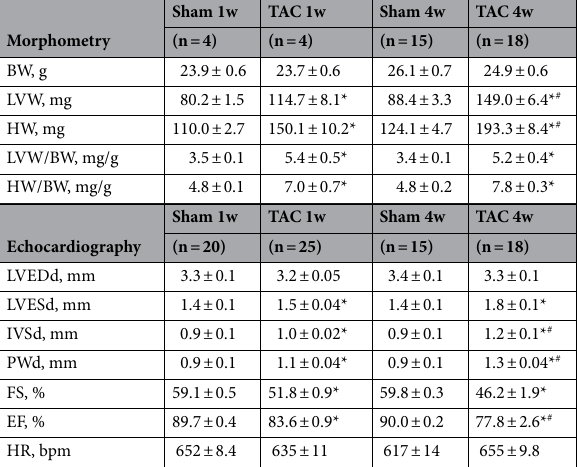
Table 1. Cardiac morphometry and echocardiography of mice from the different groups. Data are presented as mean ± SEM. An unpaired Student’s t-test was performed for each pair of four groups and subsequent multiple comparisons were made with use of the Tukey method. A p value < 0.05 was considered significant (*p < 0.05 vs. correspondent sham; # p < 0.05 vs. correspondent TAC 1w). BW Body weight, LVW left ventricle weight, HW heart weight, LVEDd left ventricular end-diastolic diameter, LVESd left ventricular end-systolic diameter, IVSd interventricular septum end-diastolic diameter, PWd posterior wall end-diastolic diameter, FS fractional shortening, EF ejection fraction, HR heart